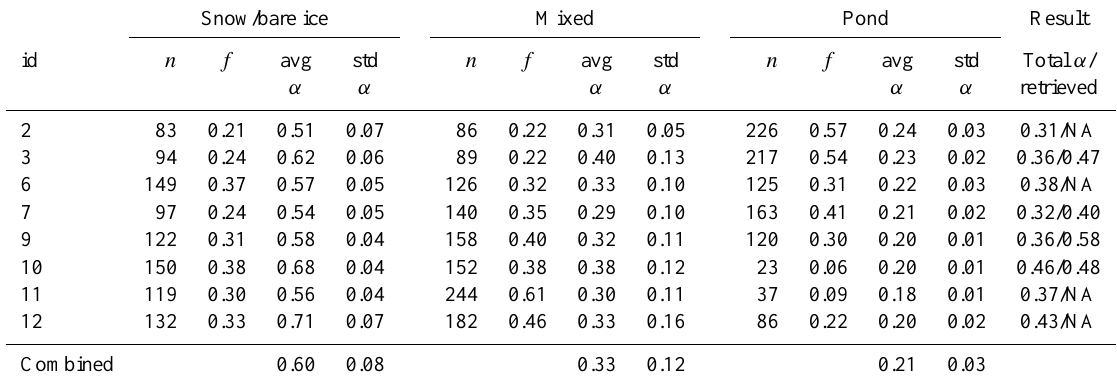
Table 3. Integrated (320–950nm) albedo for various surface types and total obtained from transect radiance measurements in Canadian Arctic, POL-ICE 2006, vs. corresponding retrieved broadband (400–900nm) albedo averaged within 5km around the location. n is the amount of measurements, f is the surface type fraction, α is the integrated